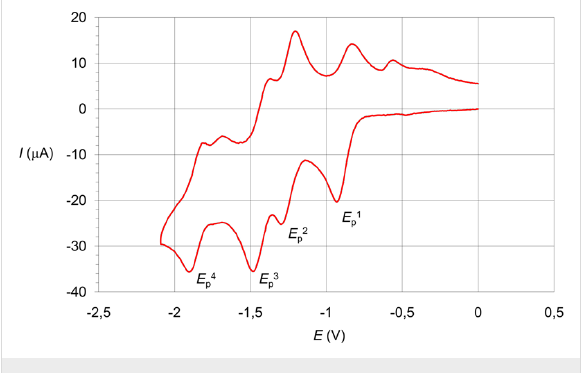
Figure 3: Cyclic voltammetry curve of AIM 9